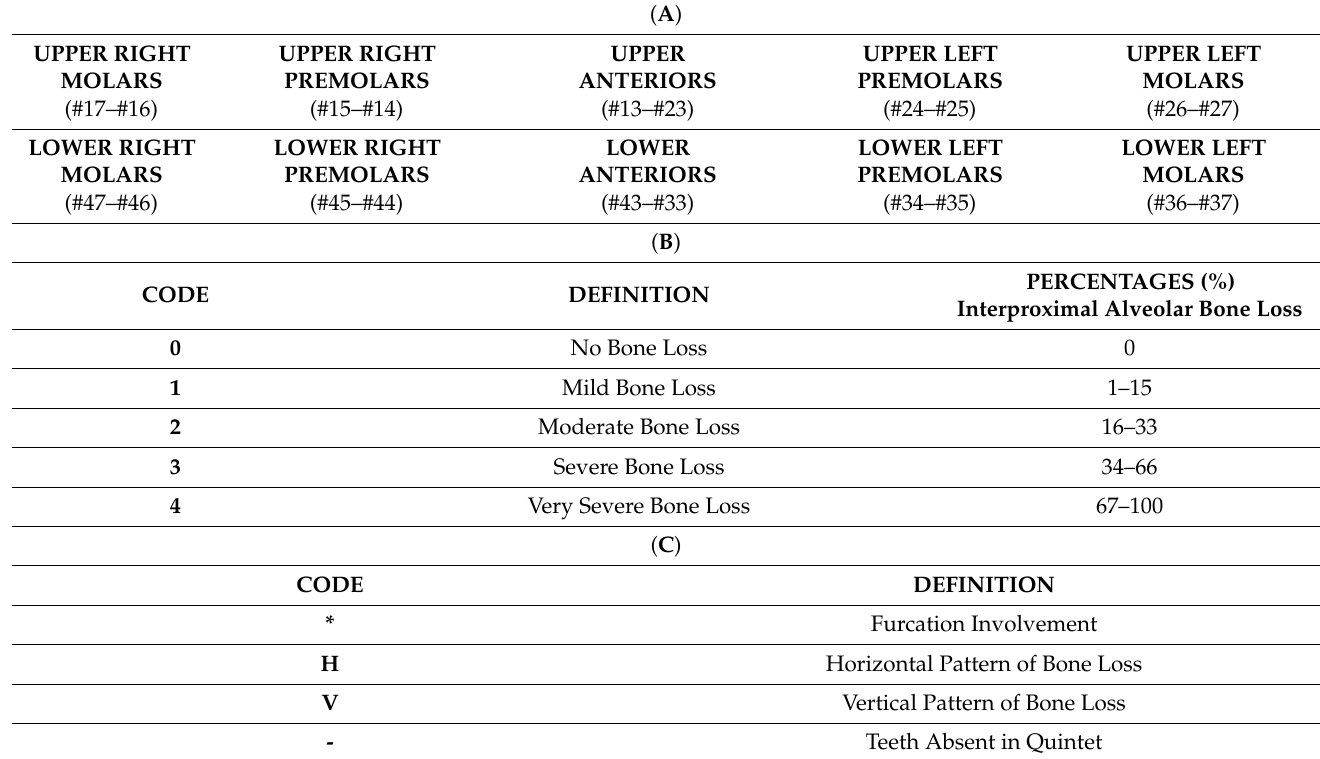
Figure 3. Radiographic interpretation in terms of periodontal bone loss pattern which is classified into ( A ) horizontal bone loss and ( B ) vertical bone loss. into ( A ) horizontal bone loss and ( B ) vertical bone loss. Table 2. ( A ) Teeth allocation in different quintets for the radiographic index. ( B ) The proposed scoring codes for the radiographic index. ( C ) The proposed additional